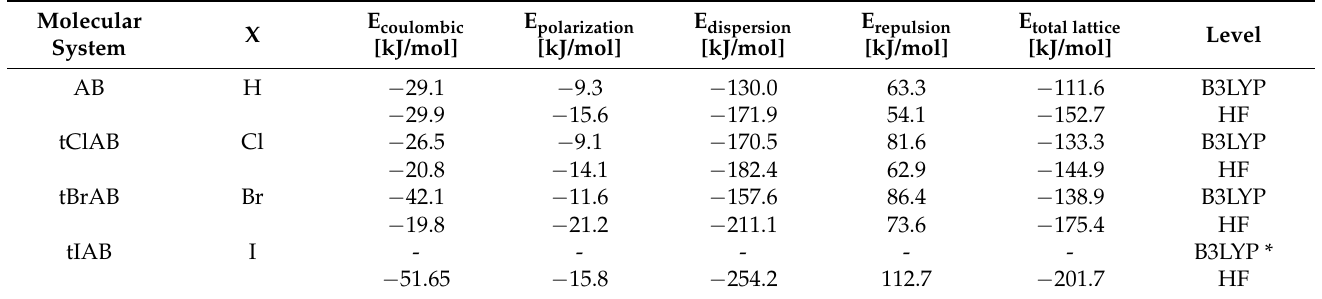
Table 4. Separation of coulombic/polarization/dispersion/repulsion terms to the total lattice calculated within Spackman scaled